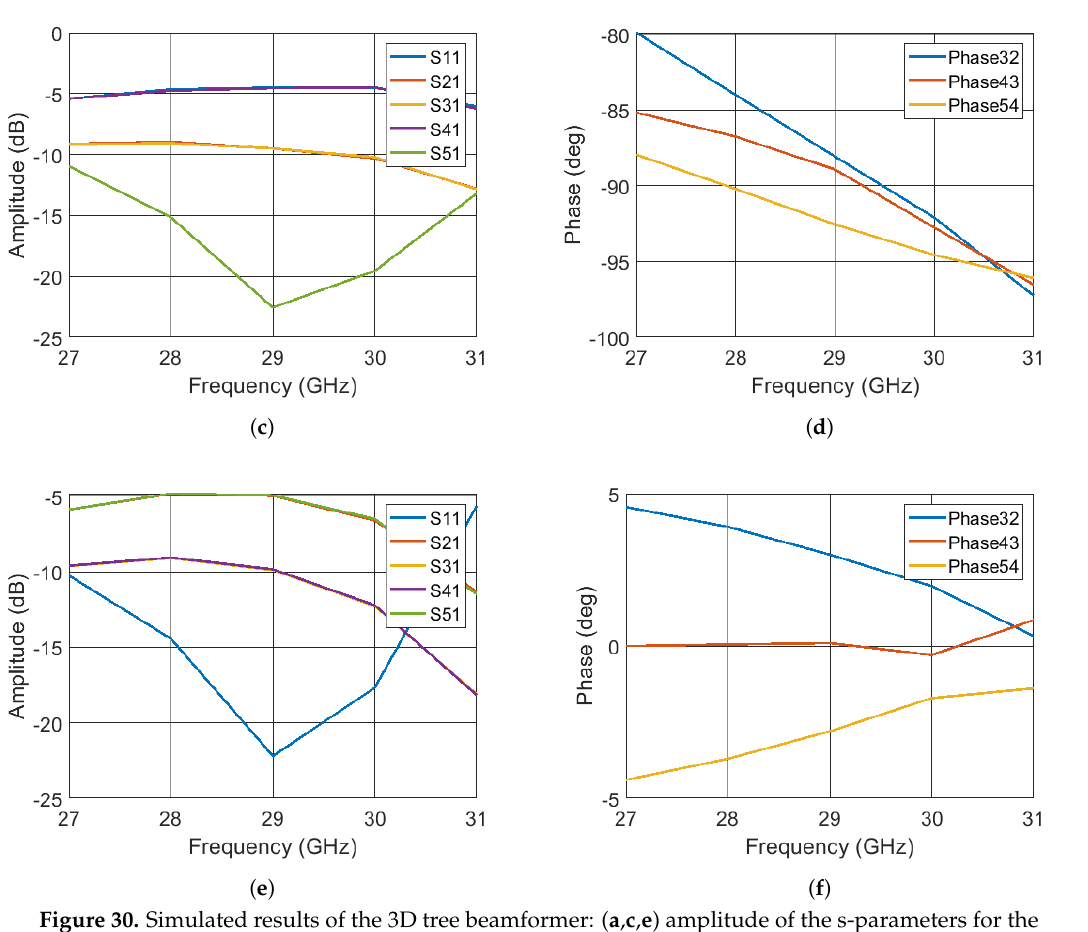
Figure 30. Simulated results of the 3D tree beamformer: ( a , c , e ) amplitude of the s-parameters for the bottom top and middle network respectively; and ( d , e , f ) the phase by the s-parameters for the bottom, top and middle network, respectively.